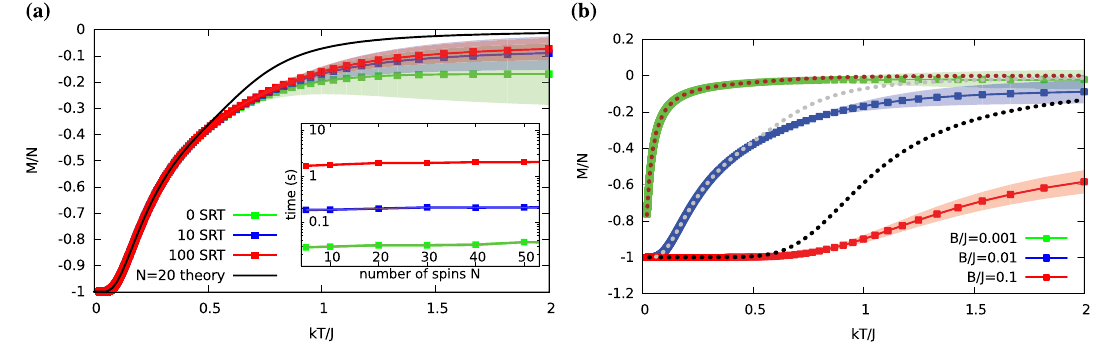
Figure 3. Influence of different number of spin-reversal gauge transforms and varying magnetic fields. ( a ) Different amounts of spin-reversal transformations (SRT) during the annealing change the sampling outcomes. For QA of the N=20 spin system with B / J = 0.01 and altogether 100 samples no, 10 and 100 SRT are used. A higher fraction of spin flips leads to more accurate predictions of the magnetization, as compared to the analytical solution (black curve). The inset shows the increasing computational demand of additional SRT. On the vertical axis, the measured QPU access time including corresponding overhead is shown as function of the number of spins in a logarithmic representation. ( b ) Magnetization as function of temperature for different external magnetic fields B . The dotted lines show the exact analytical solution for the corresponding magnetic